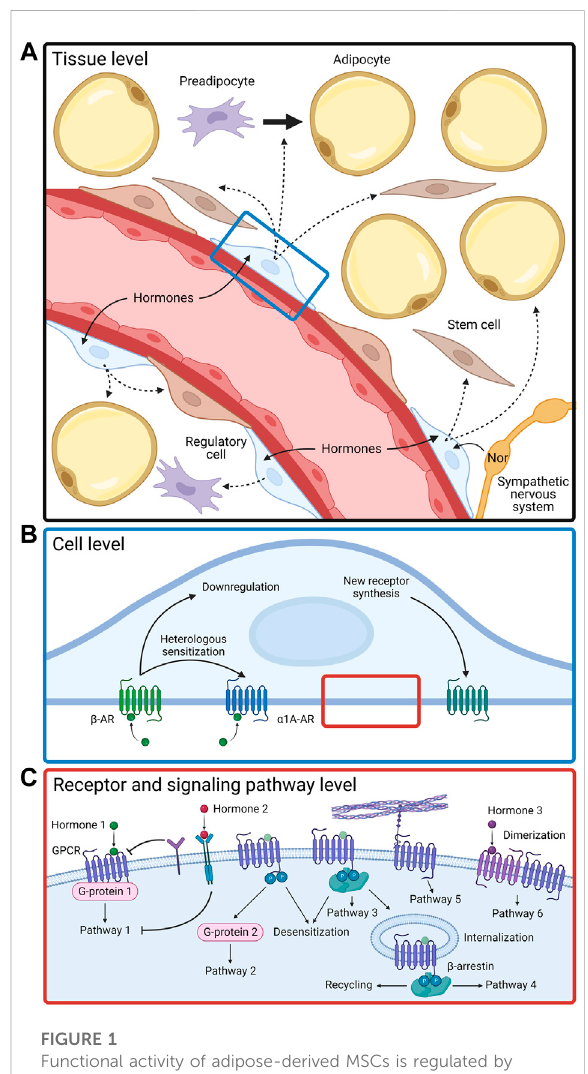
FIGURE 1 Functional activity of adipose-derived MSCs is regulated by complex mechanisms on tissue (A) , cellular (B) , and molecular (C) levels. Nor, norepinephrine; AR, adrenergic receptor; GPCR, G- protein coupled